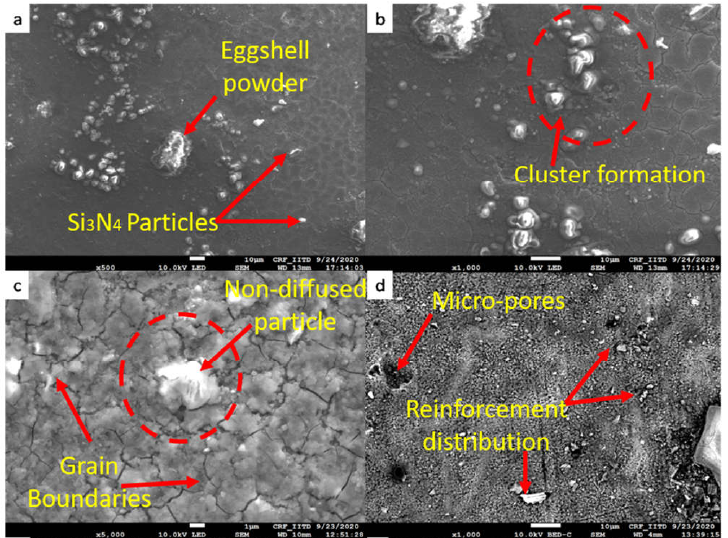
Figure 7. FE-SEM micrograph of Al359/Si 3 N 4 /Eggshell surface composites. ( a ) stir zone location 1 at 10 µm ; ( b ) stir zone location 2 at 10 µm ( c ) TMAZ location 1 µm ( d ) TMAZ location 10 µm